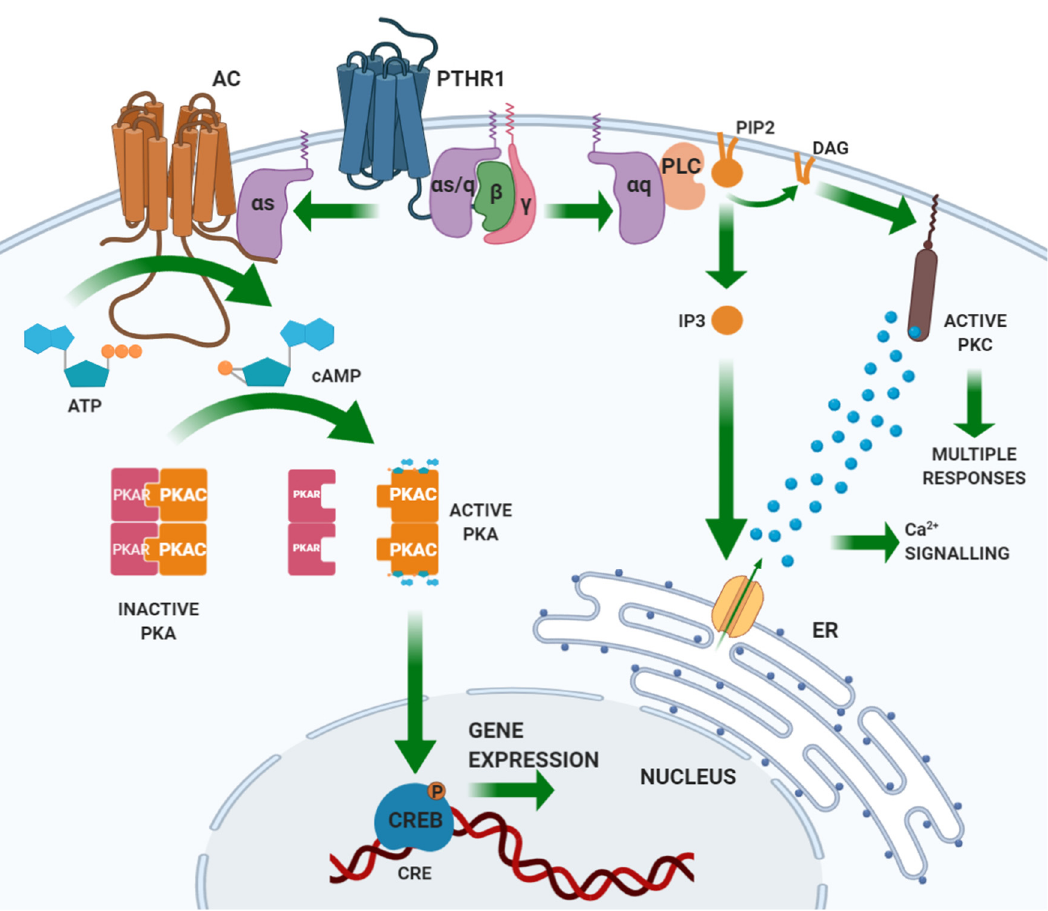
Figure 2. Signaling pathways induced by the activation of the parathyroid hormone receptor. Parathyroid hormone receptor (PTHR)1 is a class II G protein-coupled receptor. Binding of PTH to PTHR1 activates a G α s protein that activates the adenylate cyclase (AC). AC catalyzes the formation of cyclic adenosine monophosphate (cAMP) from adenosine triphosphate (ATP). cAMP binds and activates protein kinase A (PKA), which, in turn, phosphorylates the cAMP-responsive element binding protein (CREB) into the nucleus, enabling its binding to the cAMP-responsive element (CRE) on DNA and, thus, activates transcription of specific genes. Through the activation of G α q, PTHR1 activates membrane-associated phospholipase C (PLC), which cleaves the membrane phospholipid phosphatidylinositol-(4,5)-bisphosphate (PIP 2 ) into diacylglycerol (DAG) and inositol-(1,4,5)-